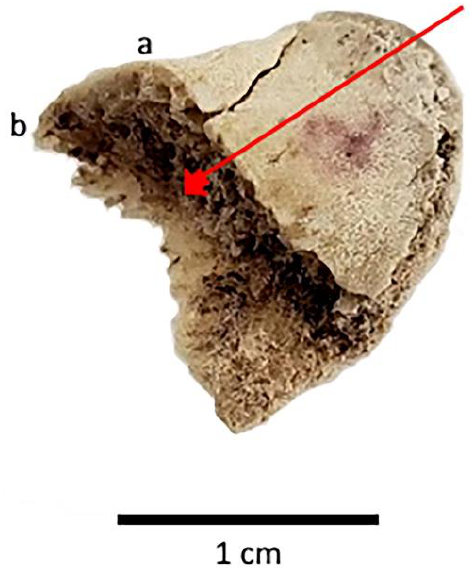
Figure 5. A Class 2 experimental chop mark made by the ground stone axe on a pig vertebra (cBI 82). The arrow indicates the direction of impact, (a) place of impact (relatively straight line where breakage begins), and (b) stepped breakage (somewhat controlled).